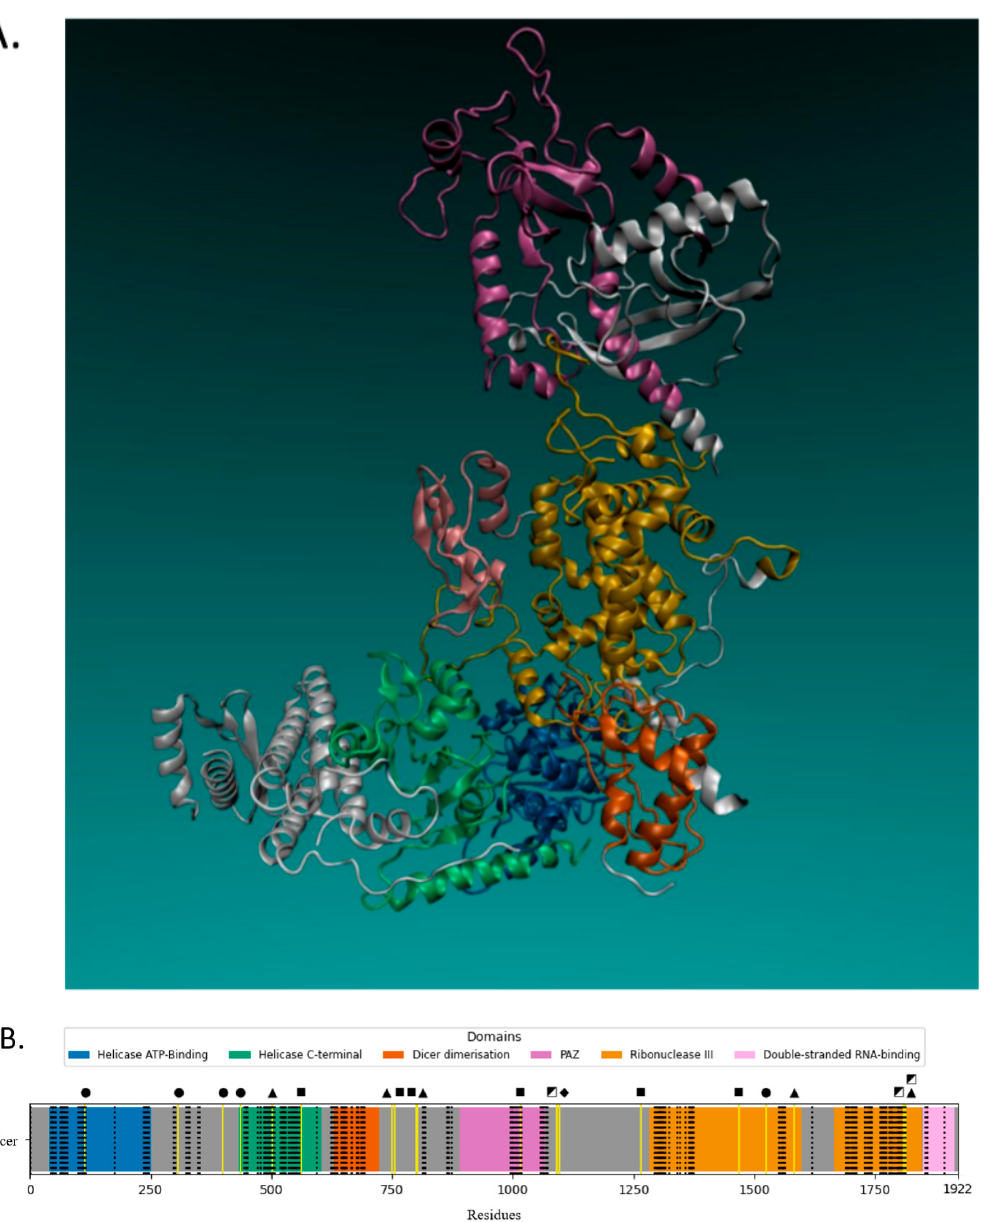
Figure 3. The majority of Dicer1 syndrome-related germline mutations of the Dicer gene are located within regions that encode the main protein’s domains. ( A ) The tertiary structure of Dicer with the protein’s main domains being highlighted (blue: helicase ATP-binding; green: helicase C-terminal; orange: Dicer dimerization; purple: PAZ; yellow: ribonuclease IIIa/b; pink: double-stranded RNA-binding). The structural data of the RCSB (Research Collaboratory for Structural Bioinformatics) PDB (Protein Data Bank) (rcsb.org) entry having the ID 5ZAK in New Cartoon representation, as displayed by VMD software. The Schrödinger Maestro Suite program (Schrödinger Release 2020-2) was applied to process the data; existing water molecules and ligands were removed and missing loops and side chains were filled (Prime). The protonation states were calculated, on physiological pH 7.4 (PROPKA), and the free energy of the resulting structures was minimized with the OPLS3 force field. ( B ) Germline mutations (yellow vertical lines) of the Dicer gene related to Dicer1 syndrome are presented at specific sites of the Dicer protein ( ■ = deletion; ◩ = deletion/insertion; ● = duplication; ◆ = insertion; (cid:78) = transversion). Domain information was retrieved from the EMBL-EBI Interpro database. Plots were generated with Matplotlib and Seaborn Python packages. The binding sites (black dashed lines) are depicted with vertical dotted lines and were calculated with Schrödinger SiteMap on default